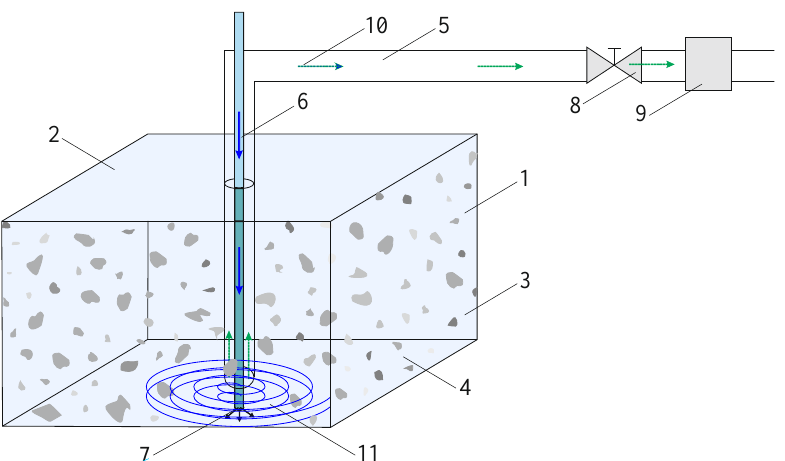
Figure 6. Scheme for the research on gas hydrate dissociation. 1: glass tank; 2: lid of the tank; 3: formed gas hydrate deposit; 4: rock intercalation; 5: outer pipeline; 6: inner pipeline; 7: outlet of the heat-transfer agent; 8: tap; 9: gas meter; 10: gas outlet; 11: pumping of a heat-transfer agent; 12: dissociation zone.